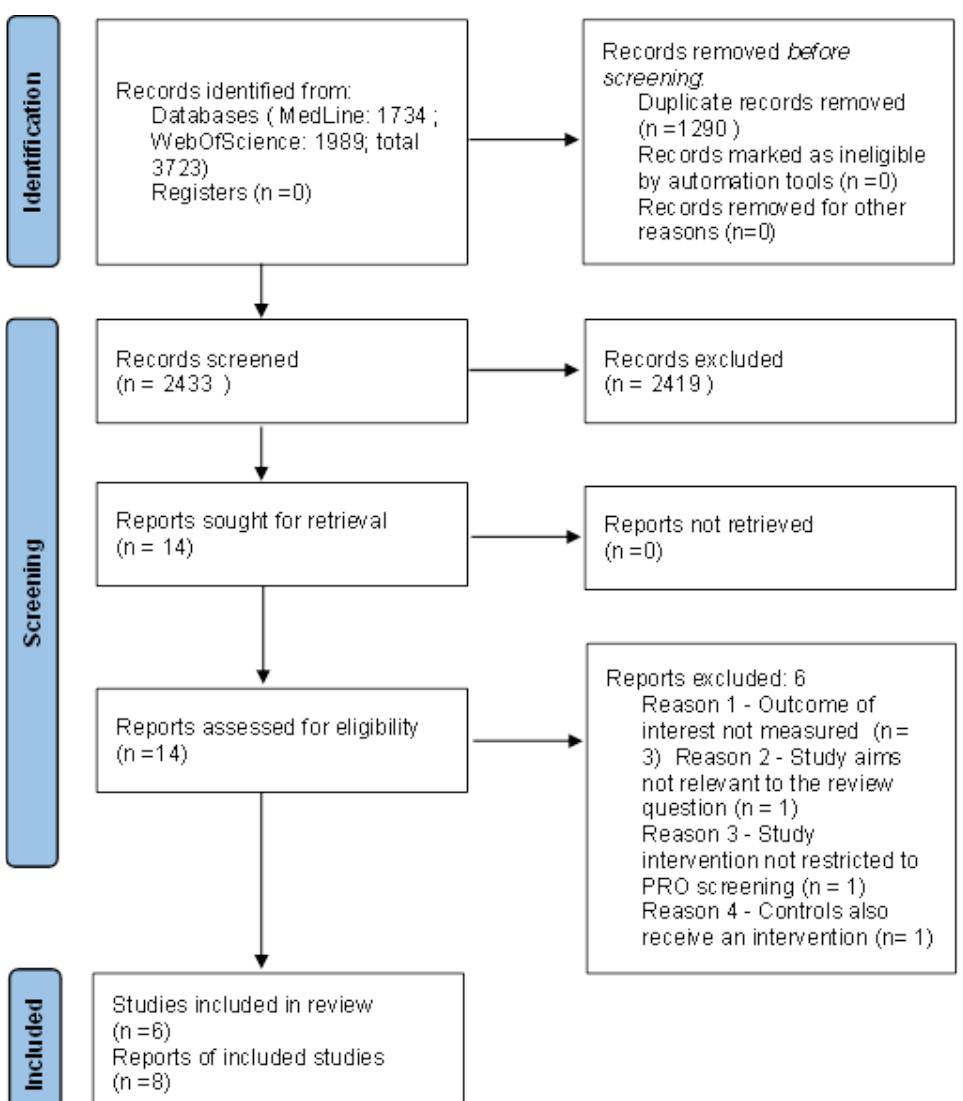
Figure 1. A PRISMA 2020 flow diagram of the process of identifying studies (both included and excluded).